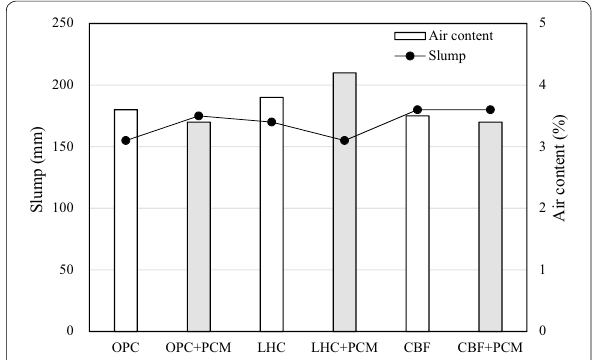
Fig. 2 Slump and air content of fresh state concrete.